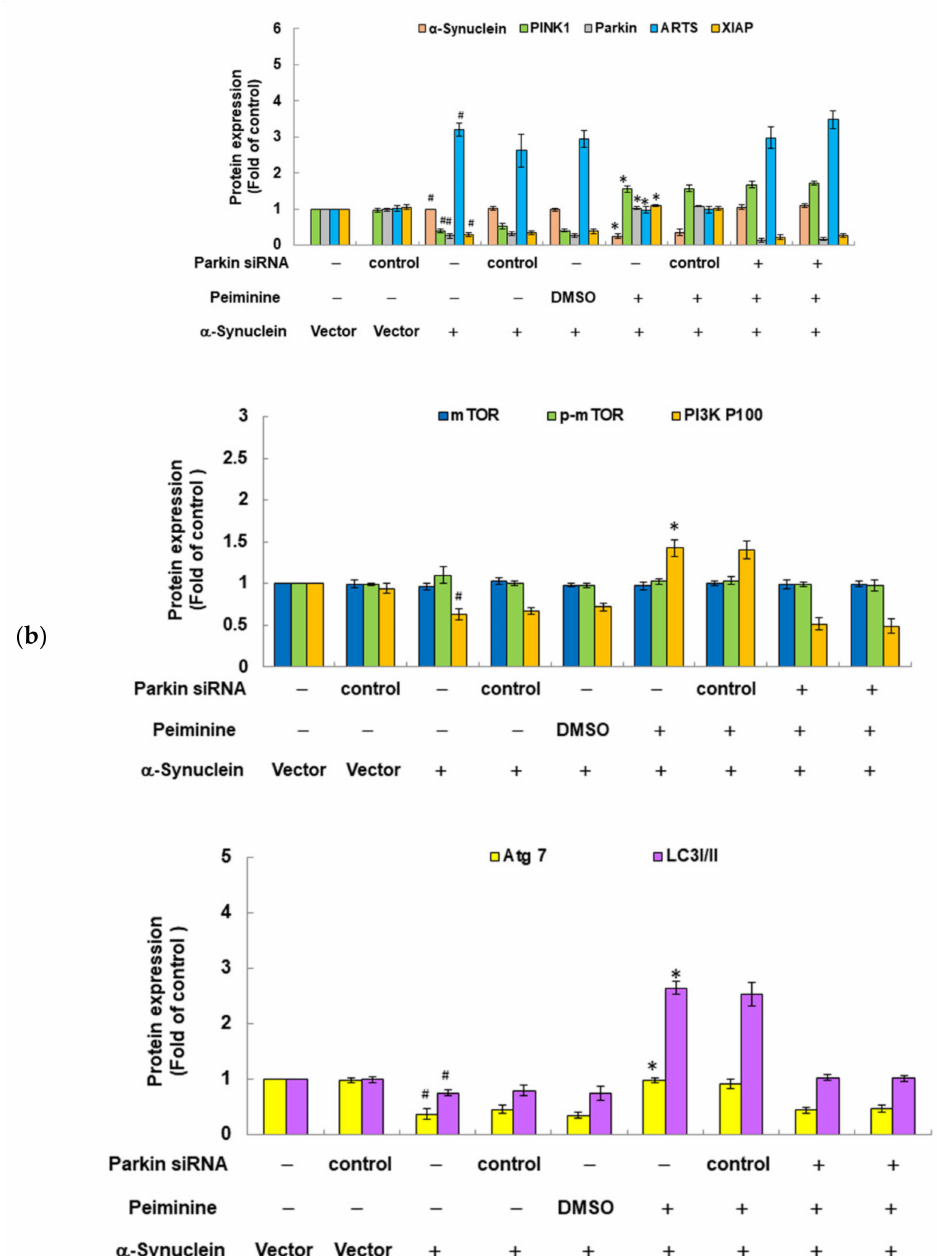
Figure 12. Western blot analysis was used to quantify the protein levels of PINK1, parkin, ARTS, XIAP, and autophagy core proteins. α -Synuclein-overexpressing SH-SY5Y cells were transfected with control siRNA or parkin siRNA for 24 h. Next, the transfected cells were treated with 1 µ M PMN or untreated for 24 h and then analyzed. ( a ) Shows representative results from one of three independent experiments. ( b ) ImageJ software was utilized to quantify the signal intensity of the image in ( a ). The loaded internal control was the level of β -tubulin. The relative ratio is represented as the ratio of each group to the control group. # Indicates a significant difference between the α -synuclein-overexpressing group and the control group ( # p < 0.001). * Indicates a significant difference between the PMN-treated group and the PMN-untreated group (* p <